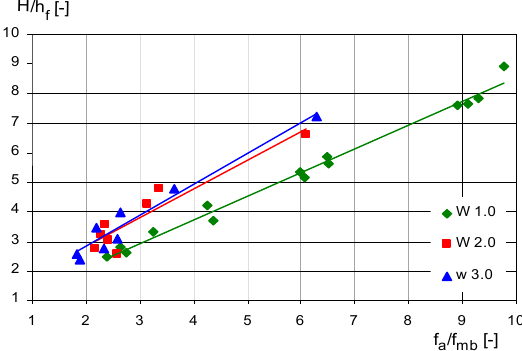
Figure 9. Values of resistance coefficients in the division plane and bottom of the main channel f a / f mb as function of relative depth H/h f .